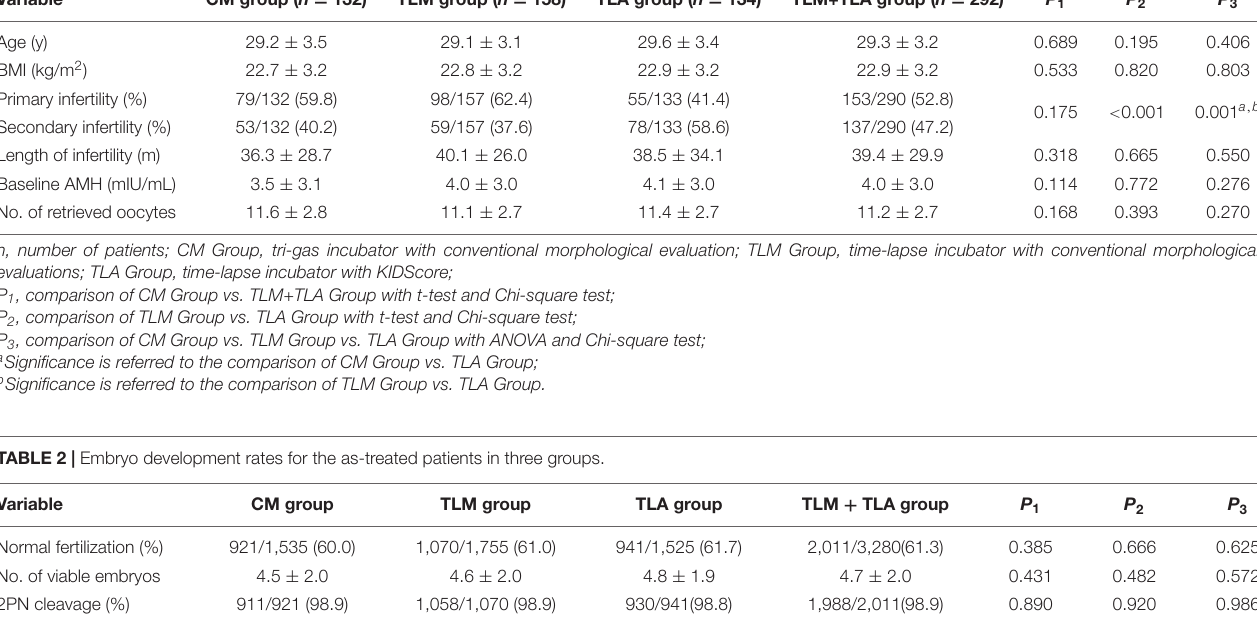
TABLE 1 | Demographic and cycle characteristics for the procedure-completed patients in three groups. Variable